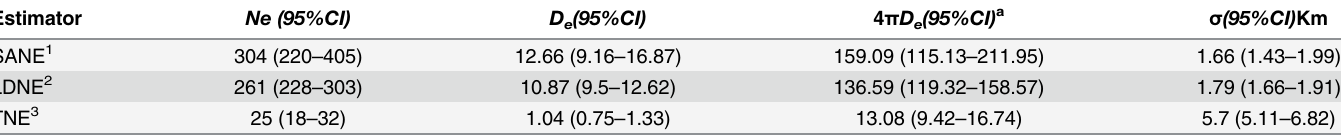
Table 2. Estimates of the effective dispersal distances based on calculation of Wright's neigborhood size N b 438.52. The effective denisty D e was calculated for a study area of 24km 2 . The mean-squared parent-offspring distance σ was calculated for each estimate of D e .